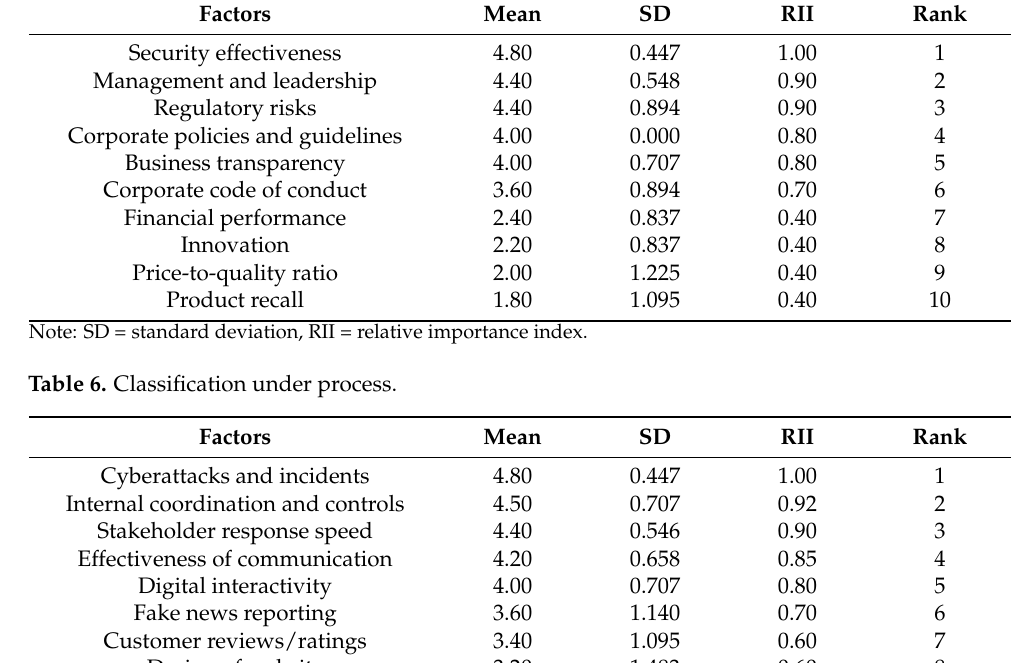
Table 5. Classification under structure.